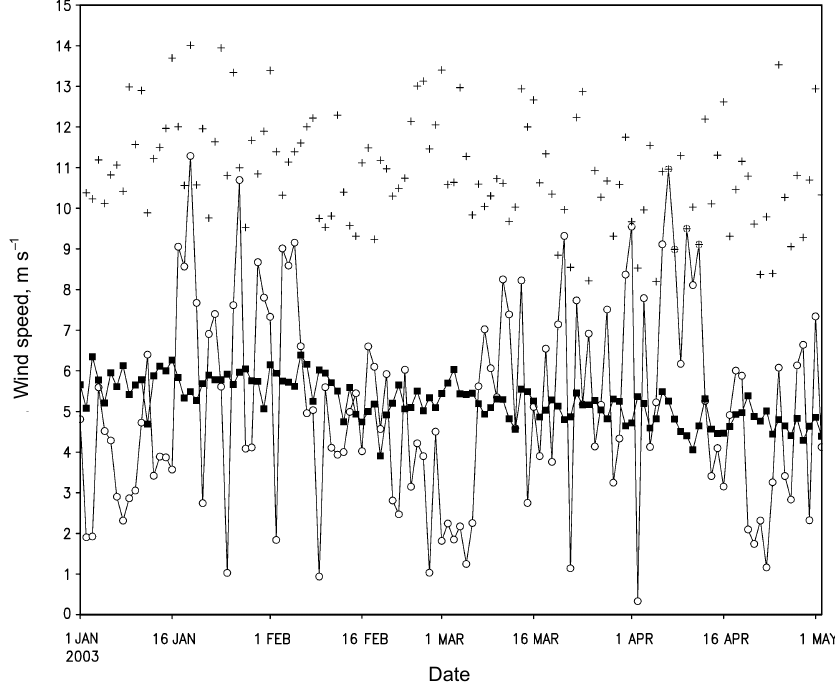
Fig. 4. Daily wind speed from NCEP/NCAR reanalysis for winter 2002/03 (circles), and mean (squares) and maximum (crosses) daily wind speeds during